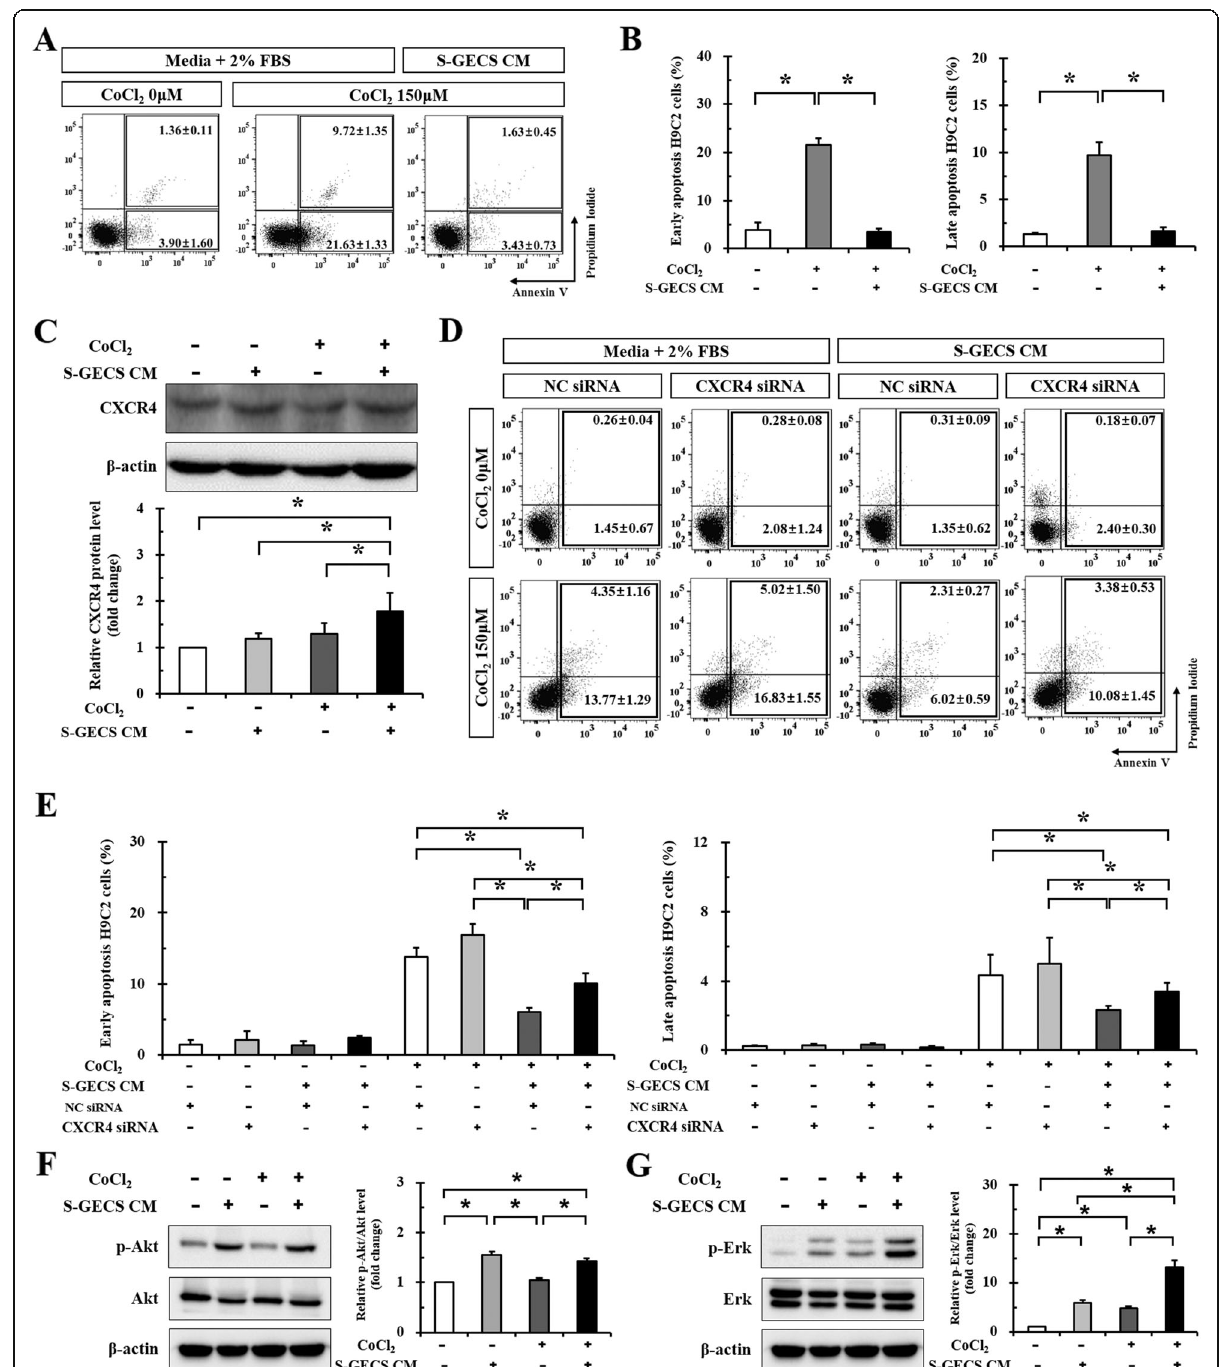
Fig. 3 Cardioprotective effects by SDF-1 α secreted from S-GECS in hypoxic injury. a The effect of S-GECS CM on early and late apoptosis of CoCl 2 -treated cardiomyoblasts. b Changes in the proportion of early apoptotic (AV+/PI-) cardiomyoblasts during CoCl 2 -induced hypoxic injury after S-GECS CM treatment, each in triplicate. * p < 0.05. c Western blot analysis of CXCR4 expression in H9c2 cardiomyoblasts treated with CoCl 2 for 24 h, each in quintuplicate. * p < 0.05. d The effect of S-GECS CM and gene silencing via CXCR4 siRNA CM on early and late apopotosis of cardiomyoblasts with and without CoCl 2 treatment. e Comparisons of the proportion of early apoptotic (AV+/PI-) cardiomyoblasts with and without CXCR4 siRNA before and after S-GECS CM treatment, each in triplicate. * p < 0.05. f Western blot of Akt signaling with and without CoCl 2 and S-GECS CM treatment, each in triplicate. * p < 0.05. g Western blot of Erk signaling with and without CoCl 2 and S-GECS CM treatment, each in triplicate. * p < 0.05. Data represent the mean ±